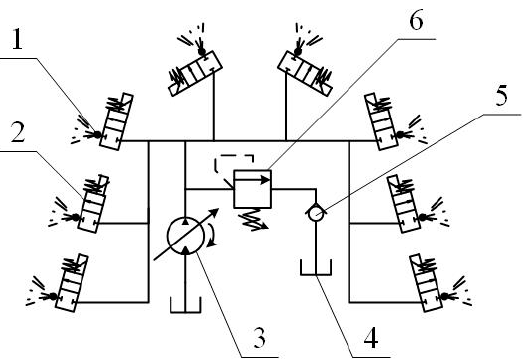
Figure 3. Diagram of hydraulic system: (1) atomizing nozzle; (2) solenoid valve; (3) high pressure pump; (4) pesticide box; (5) one-way valve; (6) relief valve.